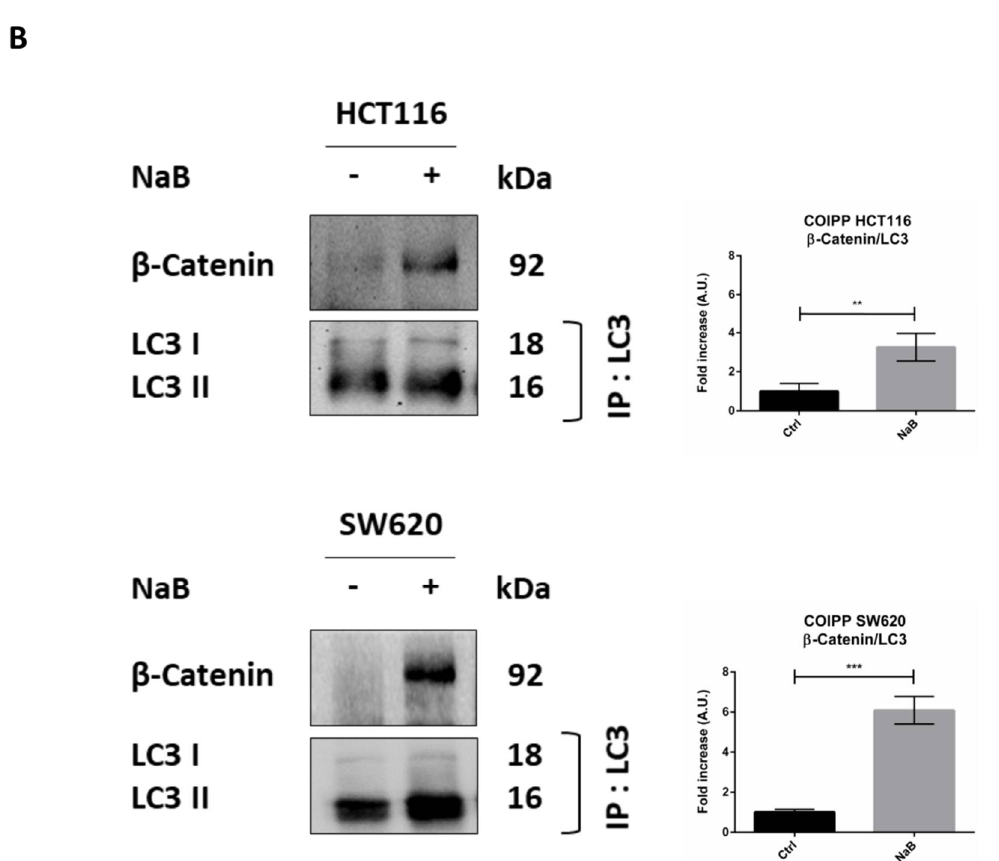
Figure 7. Sodium butyrate induces β-Catenin sequestration in the autophagy-lysosomal system. ( A ) HCT116 and SW620 cells adhering to coverslips were treated as indicated for 48 h, thereafter cells were fixed and double-stained for LC3 (green)/LAMP1 (red), β-Catenin (green)/LC3 (red), or for β-Catenin (green)/LAMP1 (red). Nuclei were stained with DAPI. The images were acquired by fluorescence microscope (scale bar = 8.5 μ m, magnification = 63×). The images shown are representative of various fields for each condition. Bars in the graph indicate the average yellow fluorescence integrity density. Data are from three different images for each condition. The graphs represent the yellow integrity density ± SD (significance was considered as follow: * p < 0.05, ** p < 0.01). ( B ) A parallel set of cultures in petri dishes was processed for co-immunoprecipitation analysis of LC3 interacting protein. LC3 and β-Catenin were revealed by Western blotting. The experiment was performed three times with similar results. Densitometric data are shown in the panel. The graphs represent the average ± SD (significance was considered as follow: ** p < 0.01, *** p < 0.001).